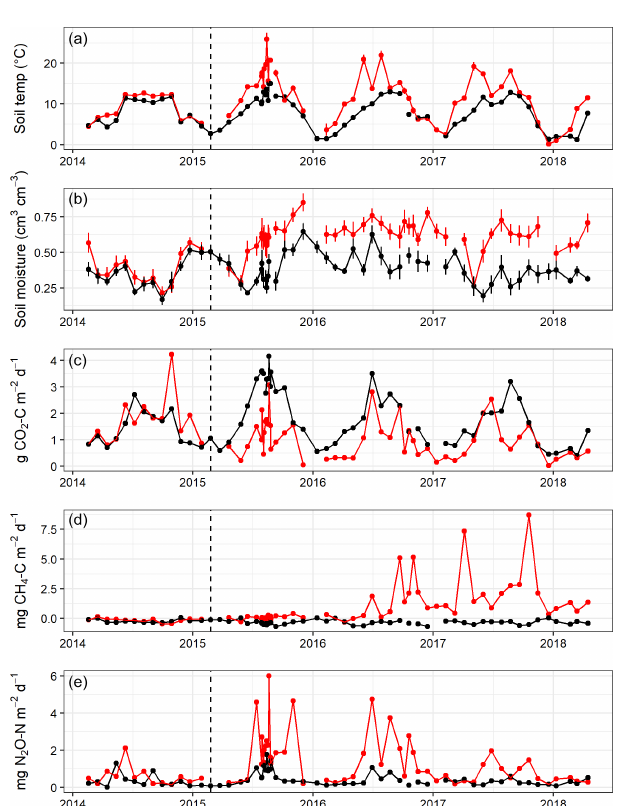
Figure 2. Mean soil temperature ( ◦ C) at 2cm depth (a) , volumetric soil moisture content (cm 3 cm − 3 ) (b) , and median soil CO 2 (c) , CH 4 (d) , and N 2 O (e) fluxes measured from eight chambers per area approximately monthly throughout the experiment in Harwood Forest. Black symbols and lines are for area A (mature spruce stand, remaining) and red are for area B, (mature spruce stand, clear-felled after one year) as indicated by the dotted vertical line. Error bars are standard error of mean of eight replicate measurements of the soil temperatures and moisture.